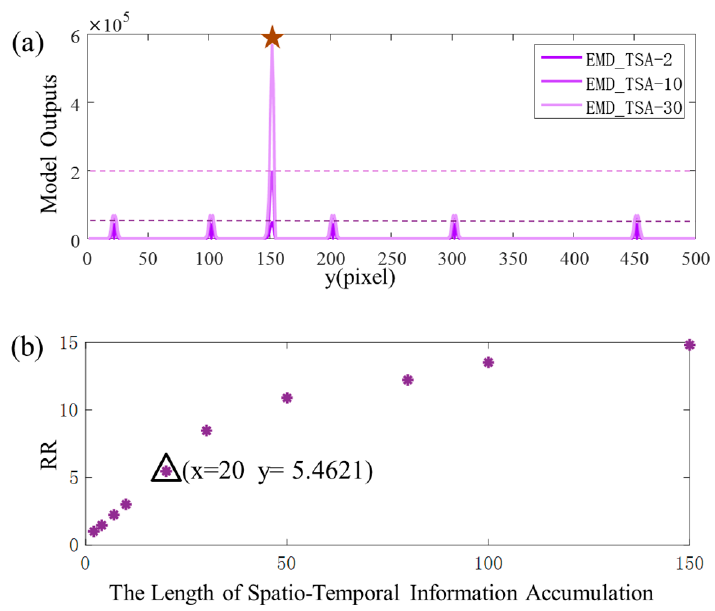
Figure 7. The output of the model under different lengths of spatio-temporal information accumulation. ( a ) The outputs of EMD_TSA-2, EMD_TSA-10, and EMD_TSA-30. EMD_TSA-2, EMD_TSA-10, and EMD_TSA-30 indicate that the length of spatio-temporal information accumulation is 2, 10, and 30, respectively. The red asterisk marks the position of the moving target. Dashed lines correspond to the peak of outputs of EMD_TSA-2, EMD_TSA-10. ( b ) The RR (response ratio) under different lengths of spatio-temporal information accumulation. Purple dots represent the values of RR under different length of spatio-temporal information accumulation.